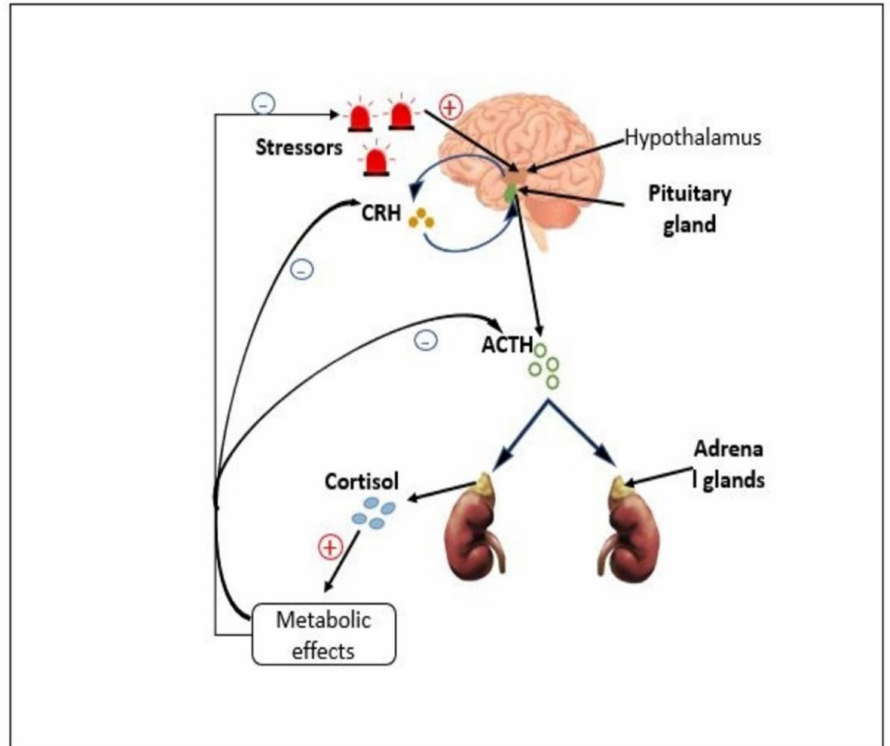
Figure 1. The hypothalamic–pituitary–adrenal (HPA) axis. As a stress response, corticotropin- releasing factor (CRF) is produced within the hypothalamus and then released into the anterior pituitary gland, where it then induces the secretion of adrenocorticotropic hormone (ACTH) into the systemic circulation. The ACTH then stimulates cortisol synthesis in the adrenal cortex, which is then released into the systemic circulation as a positive feedback mechanism for initiating necessary metabolic effects for stressor adaptation. After peak cortisol levels, negative feedback is initiated in the hypothalamus and anterior pituitary, inhibiting CRF and ACTH production, respectively, and ultimately ceasing the stress